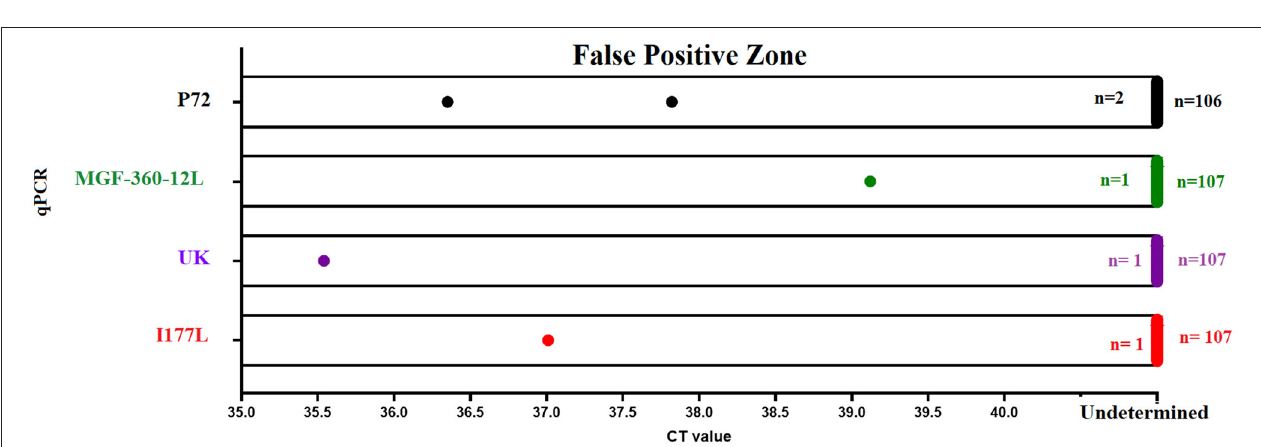
FIGURE 6 | Diagnostic specificity. The diagnostic specificity of different qPCRs was assessed using a set of 108 blood samples collected from naïve pigs. Results from different tests represent the detection of nonspecific reactions after 40 (p72 and MGF-360-12L) or 37 (I177L and UK) cycles of amplification.